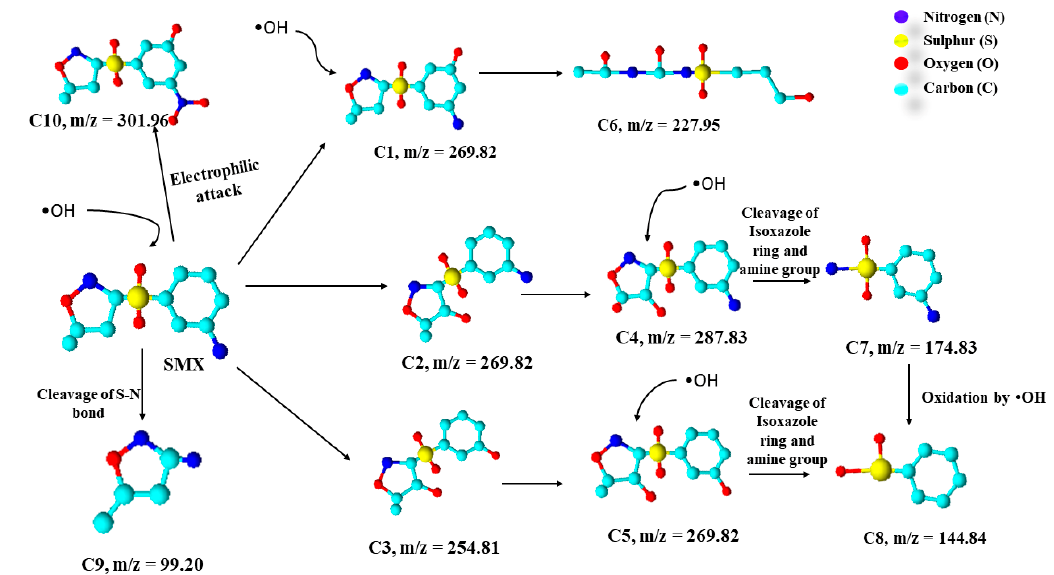
Figure 10. Photochemical degradation mechanism of SMX in water (adapted from [87,88] Copyright Year 2016 and 2017, Journal of Hazardous Materials and Chemosphere with permission License numbers: 5191250118976 and 5191390107382).